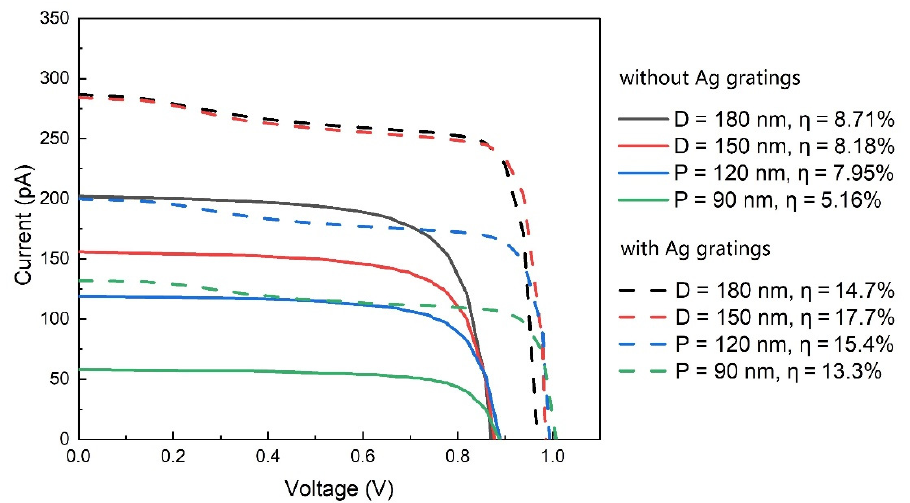
Figure 6. The current–voltage characteristics of NWs with different diameters. The grating period is 400 nm.